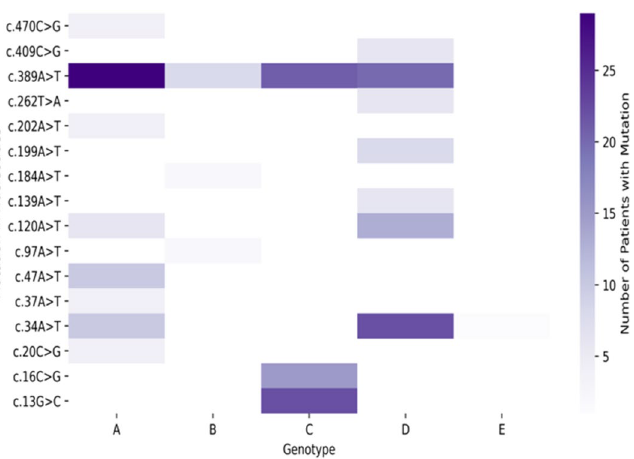
Figure 6. Heatmap of mutation hotspots for HBV nucleotide variants in genotypes A-E. The white regions represent counts of mutations that are null, while dark blue indicates the largest number of